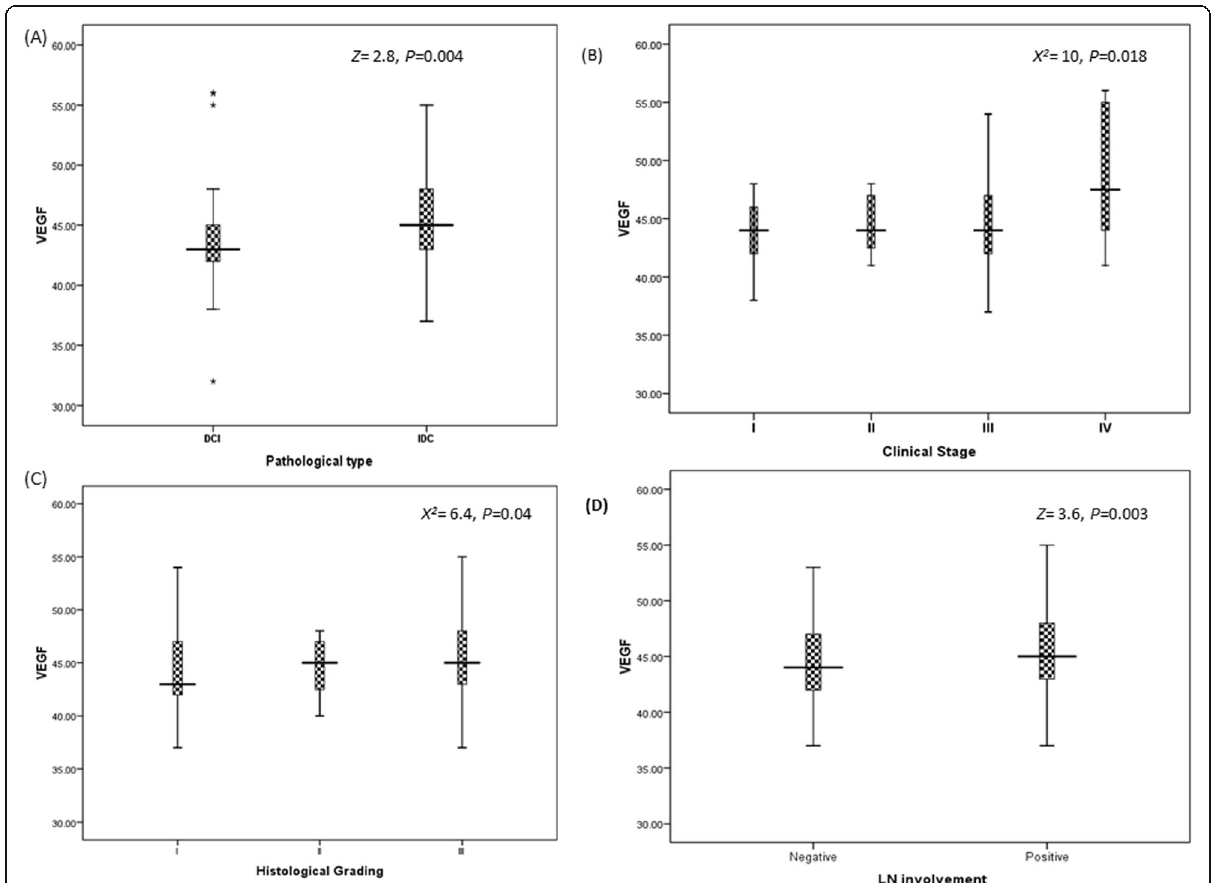
Fig. 2 Relation between miR-373 and clinico-pathological features. a Pathological types (DCI vs IDC) at X 2 =3.5 ( P <0.001). b Clinical stages (stage I to IV) at X 2 =10 ( P =0.012). c Histological grading (grade I to III) at X 2 =10 ( P =0.006). d Lymph node involvement (negative involvement vs positive involvement) ( X 2 =4.43, P <0.001). X 2 resembles the chi-square test between investigated